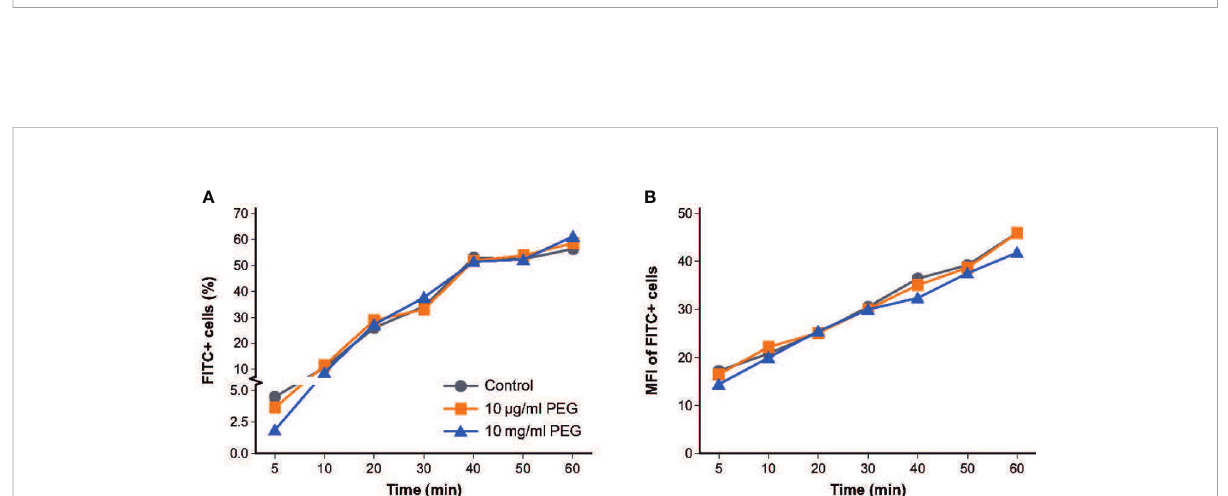
FIGURE 3 Effect of 20-kDa PEG exposure on phagocytic activity of human MDMs. (A) Percentage of MDMs that ingested FITC+ E. co li after 24 hours of PEG exposure (n = 3). (B) Mean fl uorescent intensity of FITC+ MDMs (n = 3). FITC, fl uorescein isothiocyanate; MDM, monocyte-derived macrophage; MFI, mean fl uorescent intensity; PEG, polyethylene